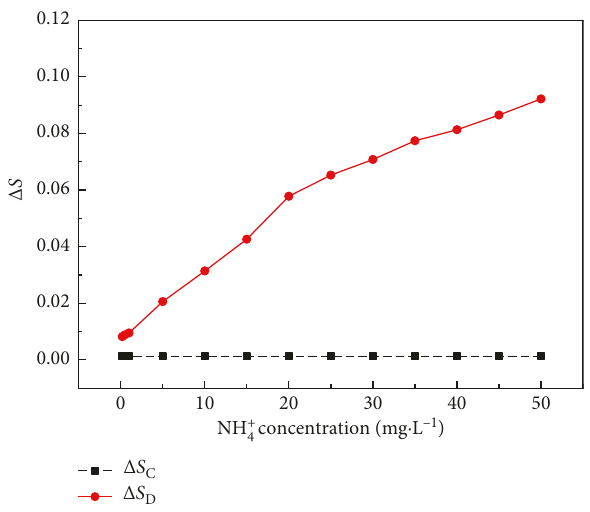
Figure 6: The detection results for various NH